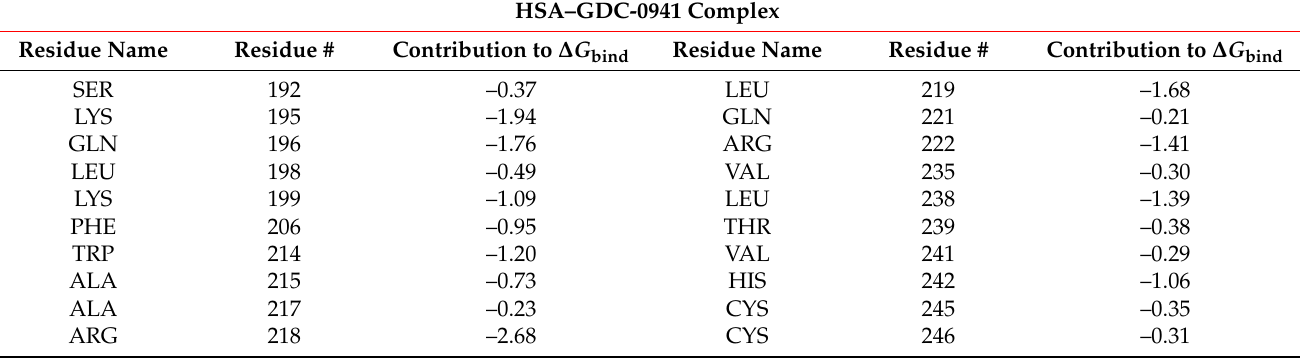
Table 1. MM-GBSA free energy of binding per residue decomposition. All values are in kcal/mol (# represents